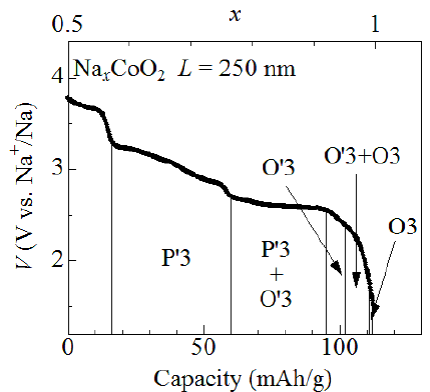
Figure 1. Discharge curves of the O3-NaCoO 2 film measured at 1.6C. The film thickness ( L ) is 250 nm. O3, O (cid:48) 3, and P (cid:48) 3 represented structural phases (cited from reference